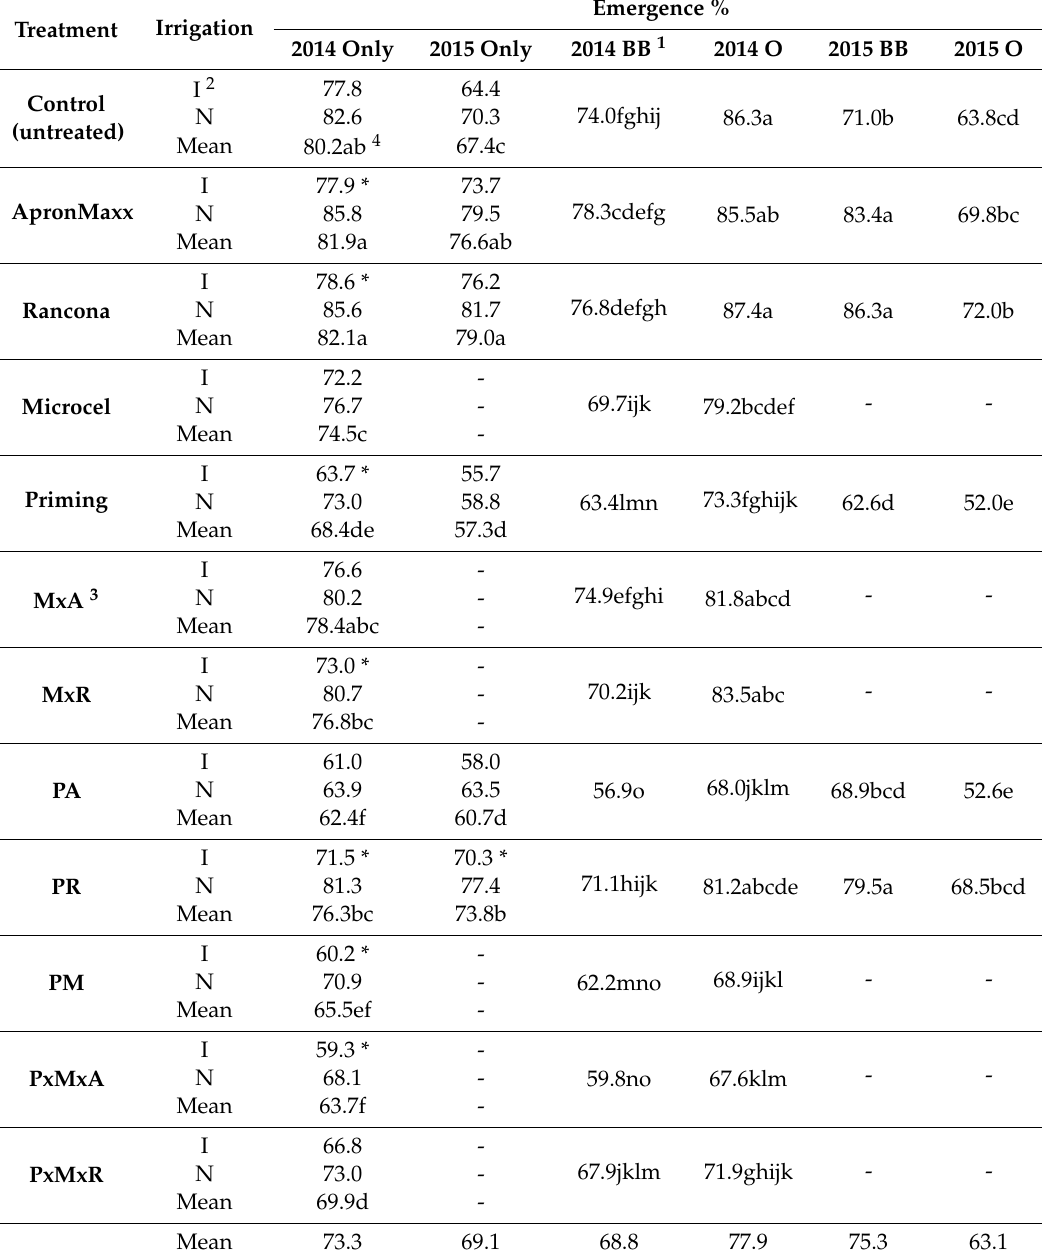
Table 4. Average field emergence and Tukey’s separation of means for 12 seed treatment combinations in 2014 and